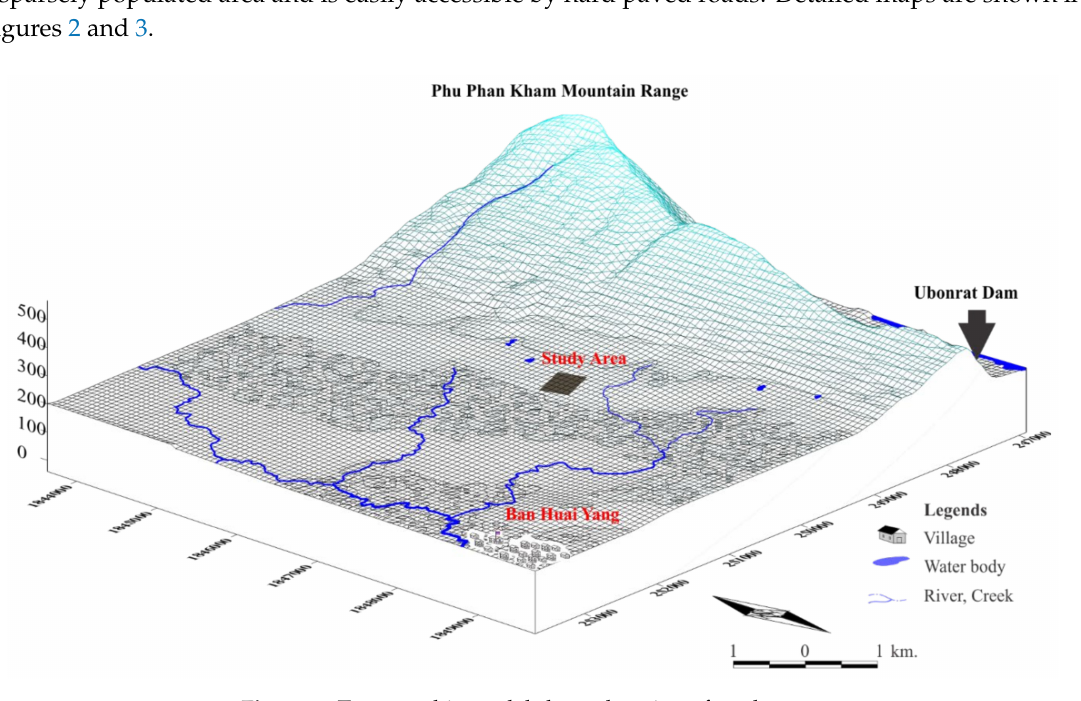
Figure 2. Topographic model shows location of study